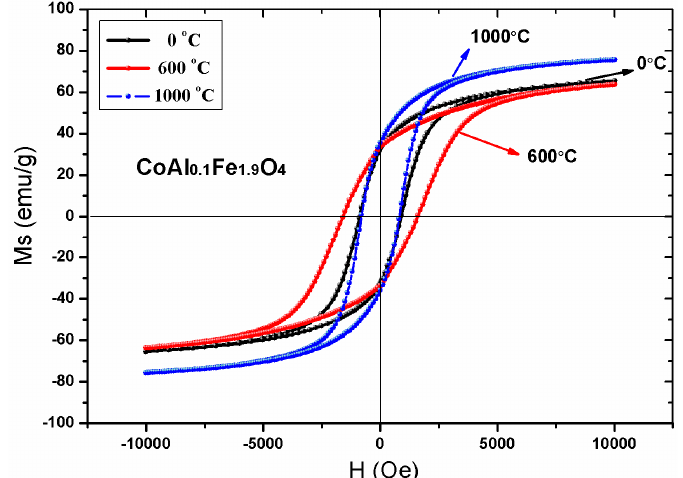
Figure 9. Room-temperature hysteresis curves of CoAl 0.1 Fe 1.9 O 4 samples calcined at different temperatures. Table 6. Magnetic data for CoAl 0.1 Fe 1.9 O 4 sample calcined at different temperatures. Temperature (°C)